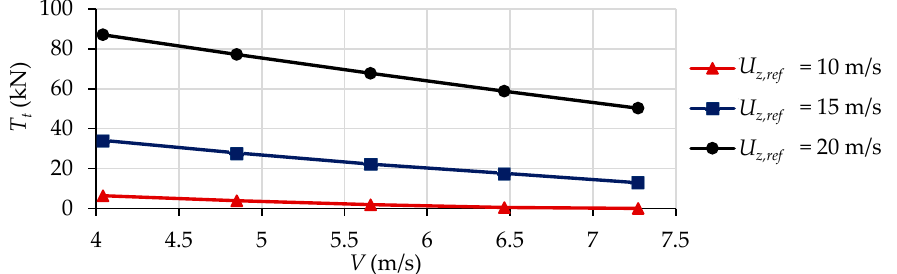
Figure 17. The tether end tensions exhibited with the optimal parameters for different wind and ship speeds and a kite area of 320 m 2 .